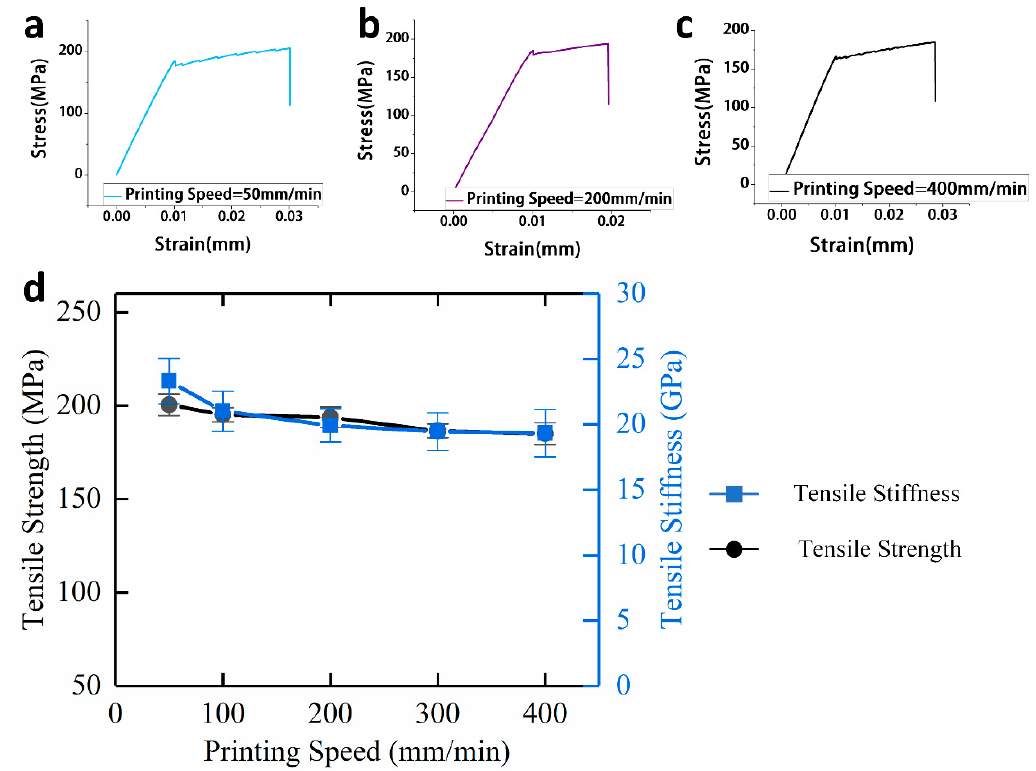
Figure 11. ( a ) Tensile stress-strain curve of specimens while the printing speed is 50 mm / min; ( b ) Tensile stress-strain curve of specimens while the printing speed is 200 mm / min; ( c ) Tensile stress-strain curve of specimens while the printing speed is 400 mm / min; ( d ) Effect of printing speed on tensile mechanical properties of continuous carbon fiber-reinforced 3D printing.